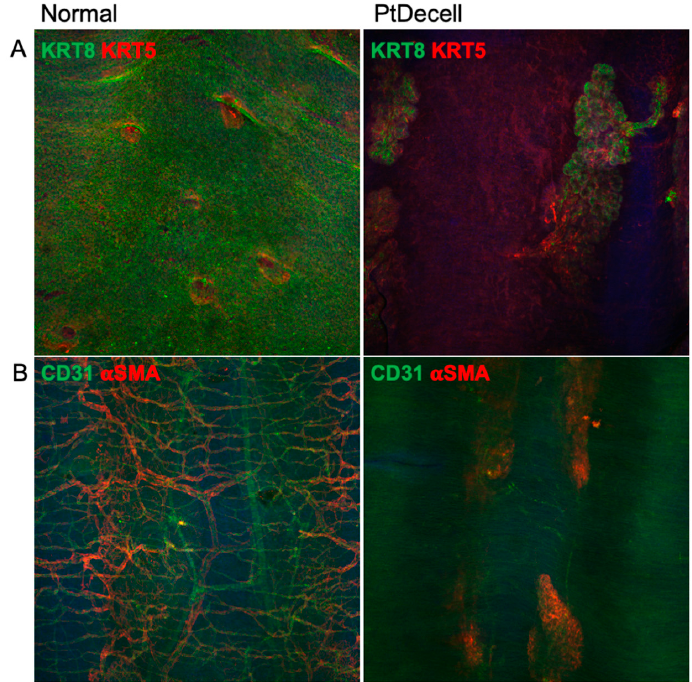
Figure 6. Whole-mount staining of partly decellularized tracheas. ( A ) Keratin 8 and Keratin 5 are markers for luminally committed differentiated cells and basal cells, respectively. Notably, the partly decellularized trachea had no “lawn” of surface airway cells, with the exception of those in the submucosal glands and ducts. ( B ) CD31 is an endothelial cell marker, and α‐ smooth muscle actin identifies muscular arteries and glandular myoepithelial cells. The decellularized trachea showed an absence of vascularity after treatment.